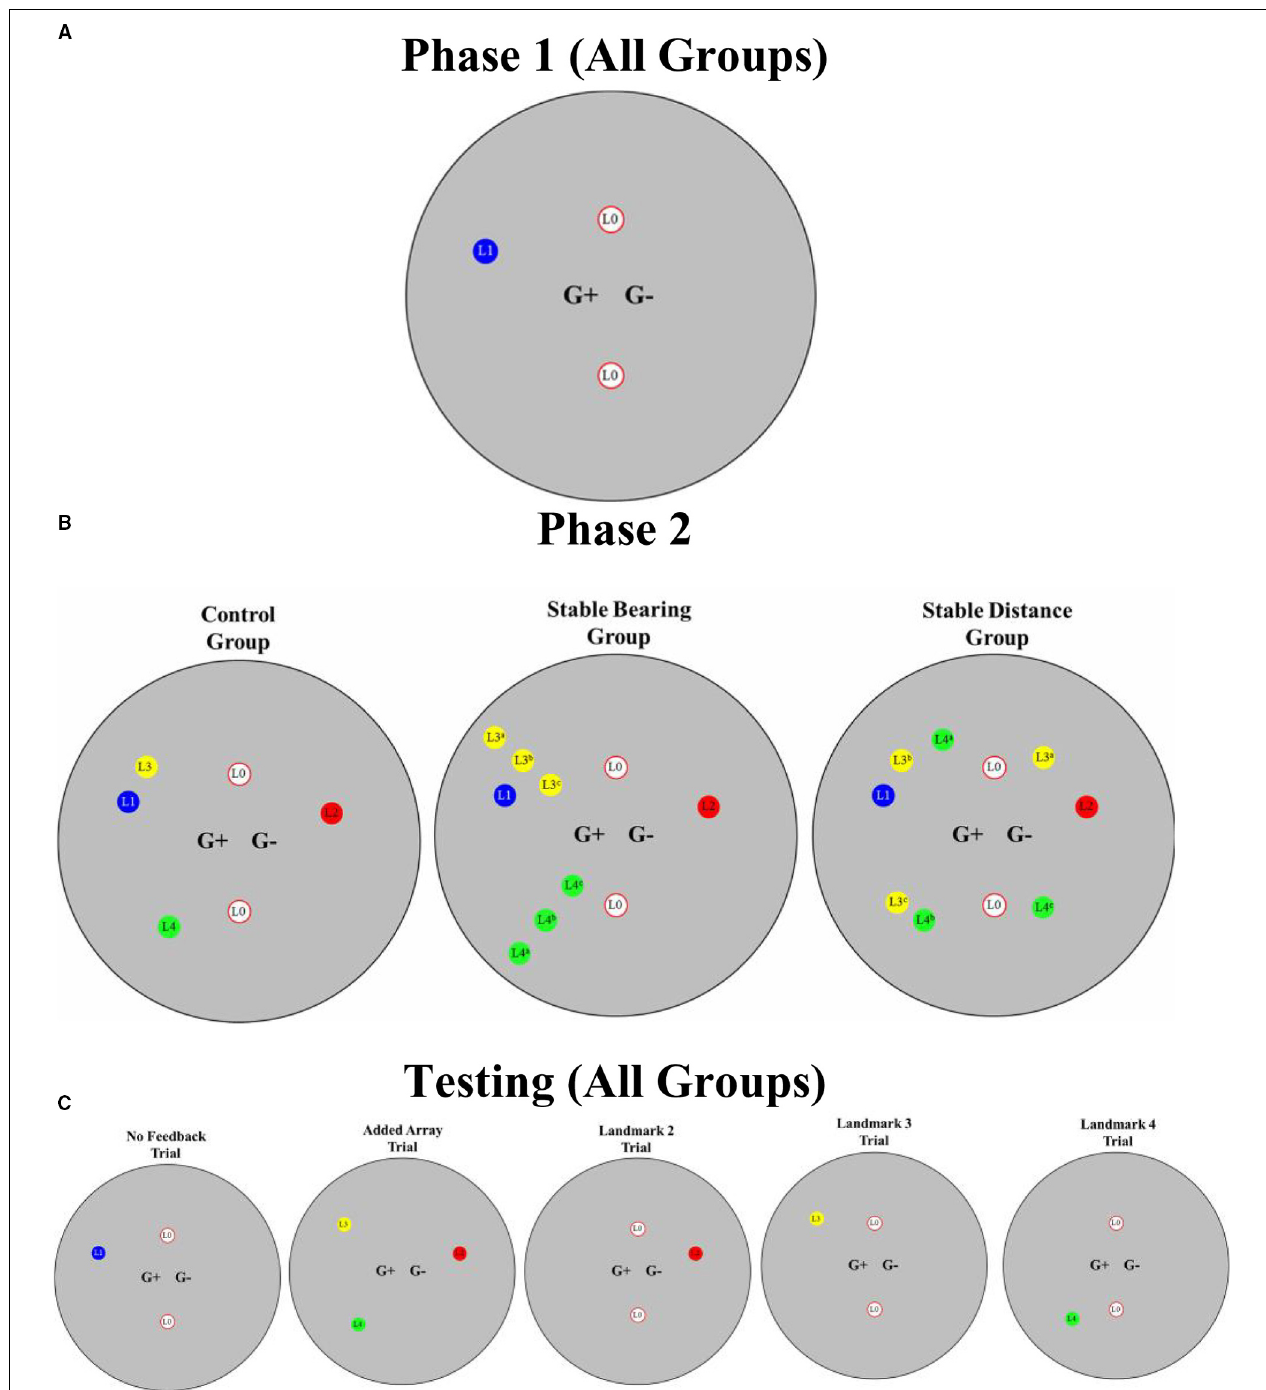
FIGURE 2 | (A) Overhead view illustrating initial training (Phase 1) for all groups. (B) Phase 2 training for each group. (C) Testing for all groups. Please note that each of the potential locations of Landmark 3 (L3 a , L3 b , L3 c ) and Landmark 4